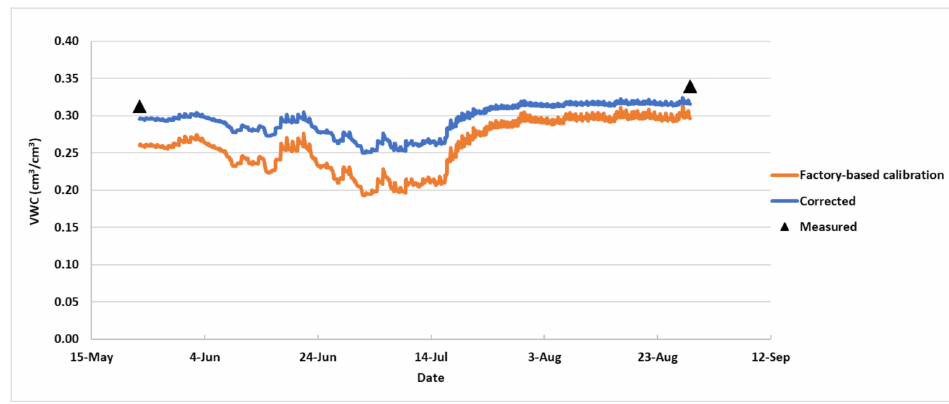
Figure 9. Comparison of factory-based calibration to corrected values for EC5 in loamy sand.